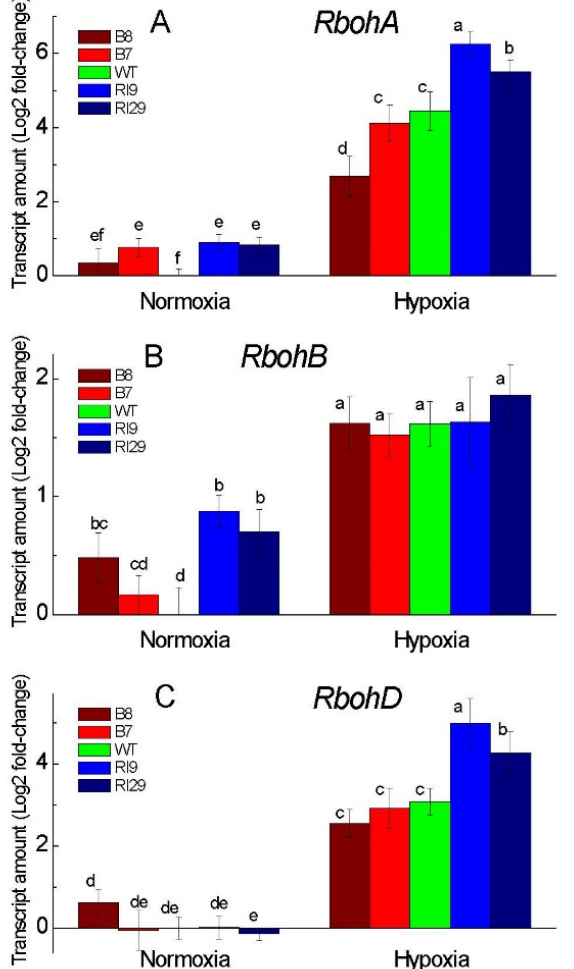
Figure 3. Transcript levels of the genes encoding the subunits RbohA ( A ), RbohB ( B ), and RbohD ( C ) of the respiratory burst oxidase homolog in leaves of tobacco plants exposed to normoxia and 6 h hypoxia. The plant lines used included wild type (WT), two alternative oxidase overexpressors (B7 and B8), and two alternative oxidase knockdowns (RI9 and RI29). Vertical bars indicate SD from three to four independent experiments ( n = 3–4); different letters indicate significant differences between five tobacco lines and the treatments.